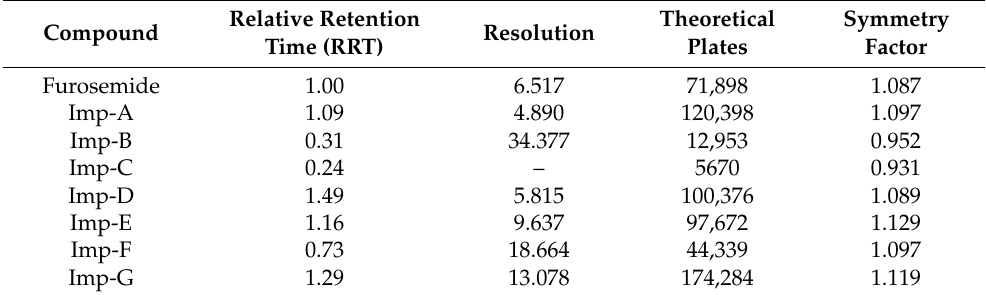
Table 2. Results for specificity.